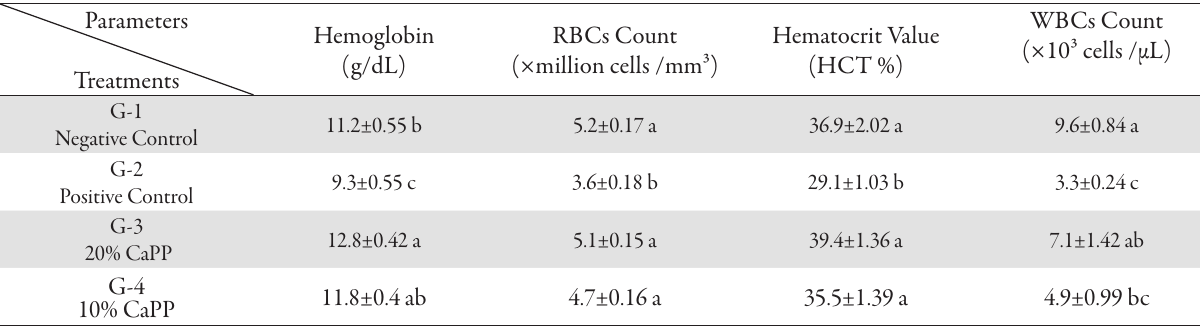
Tab. 4. Complete blood picture of the experimental rats